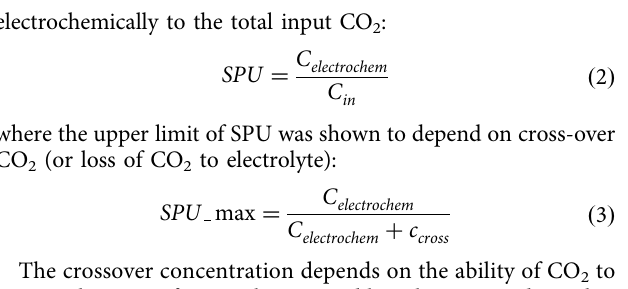
Fig. 1 A schematic of the CO 2 RR electrolyzer and relevant transport processes. The CO 2 RR electrolyzer utilizing ( a ) a bipolar membrane (BPM) and ( b ) a cation exchange membrane (CEM). Copyright: Modi fi ed from ref. 6 ., used under CC